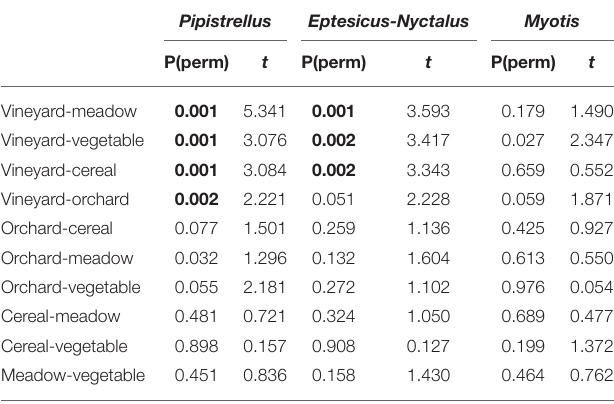
TABLE 2 | Results of pairwise comparisons (PERMANOVA) of activity levels of the 3 bat groups ( Pipistrellus , Eptesicus-Nyctalus , Myotis, see above ) between the different open landscape habitats (meadow, vineyard, orchard. vegetable, cereal).